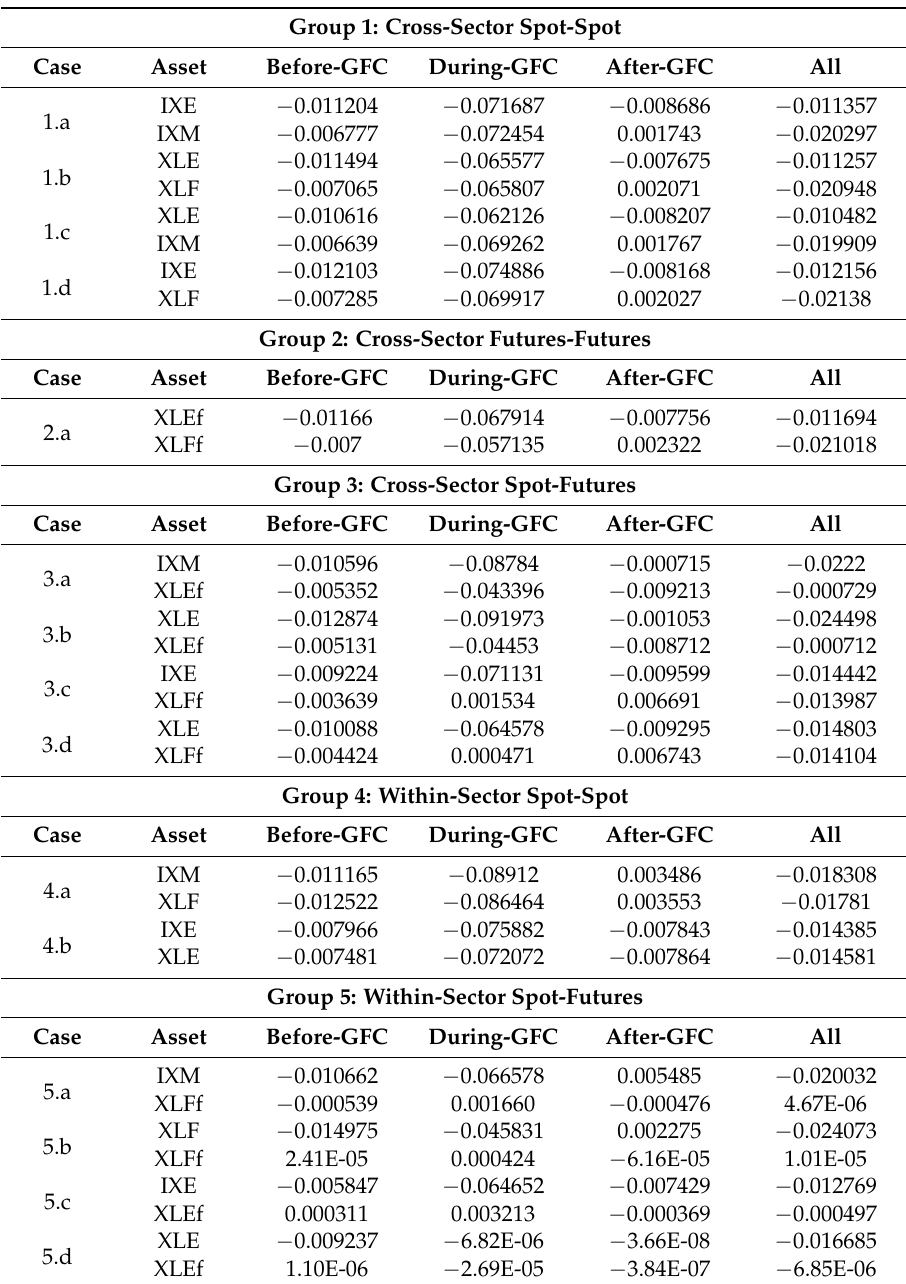
Table 5. Mean return shocks. Group 1: Cross-Sector